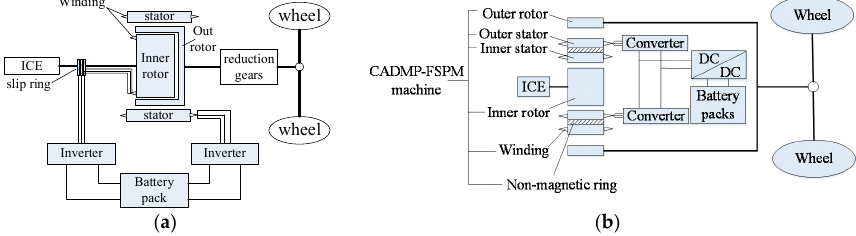
Figure 1. Comparison of dual ‐ mechanical ports (DMP) machine ‐ based and co ‐ axial dual ‐ mechanical ports flux ‐ switching permanent magnet (CADMP ‐ FSPM) machine ‐ based electronically ‐ controlled continuously ‐ variable transmission (E ‐ CVT) systems. ( a ) Scheme of an E ‐ CVT system with a